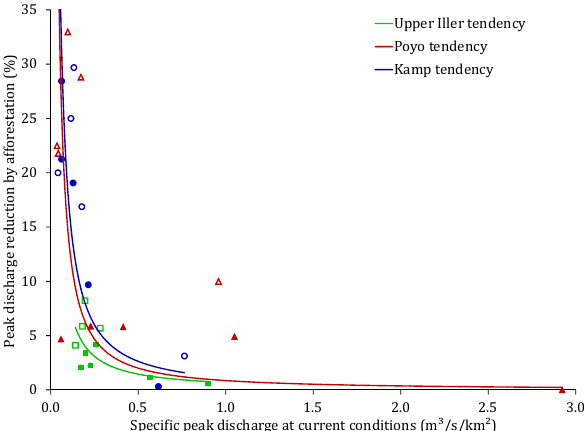
Fig. 8. Effect of the afforestation scenario on peak discharge with two initial soil moisture conditions (solid symbols means “wet” and empty symbols means “dry”) in the catchments: (a) Poyo (red trian- gles), (b) Upper Iller (green squares) and (c) at Kamp (blue circles). MAISC values are 4.0, 3.2 and 7.8mm,